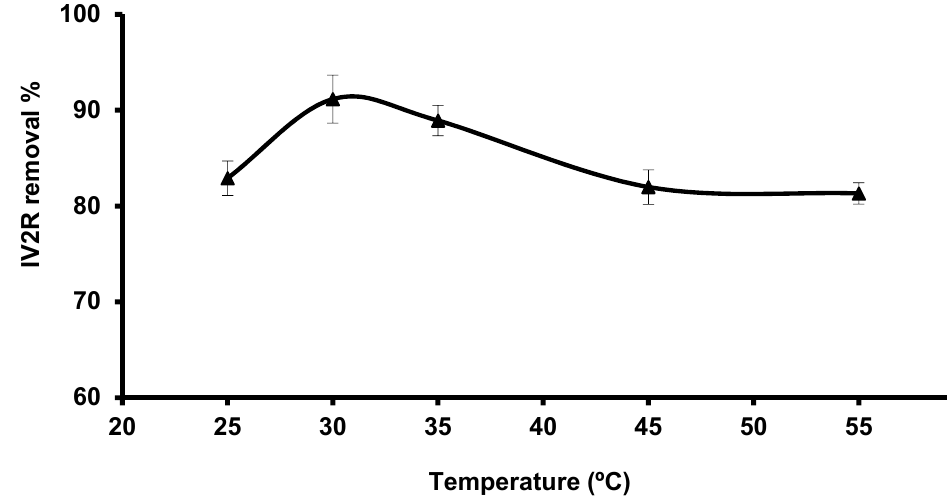
Figure 10. Influence of temperature on the removal of IV2R.